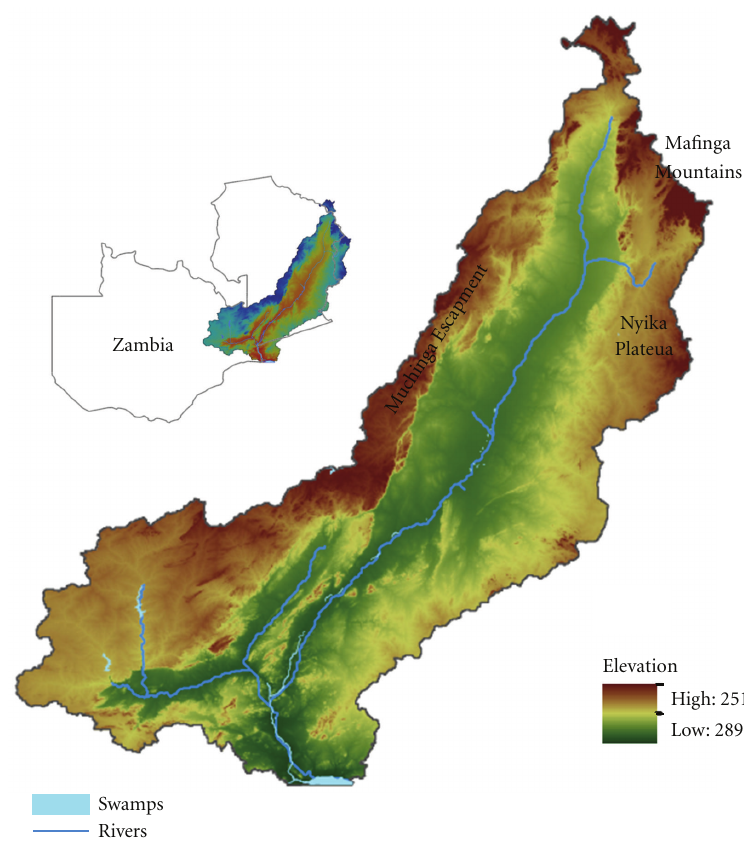
Figure 1: Shows the layout of the Luangwa valley. The Muchanga escapement is located on the western end of the valley at an altitude of 2,500 meters above sea level. The North is covered by the Mafinga mountains and Nyika Plateau while the valley flow lays below 500meter above sea level. The Luangwa river is centered at the base of the valley